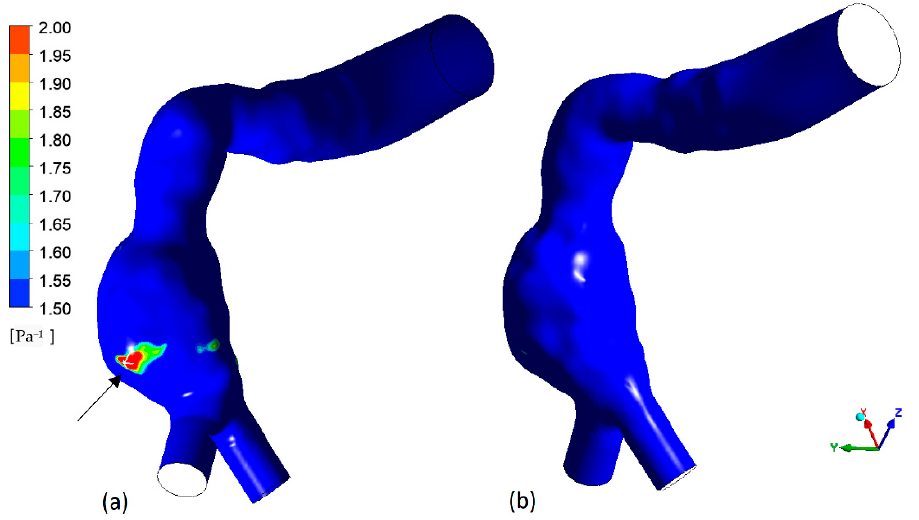
Figure 11. ECAP contours distribution on the luminal surfaces of the rupturing aneurysm: ( a ) front view, ( b ) back view. The arrow and the white cross indicate the region where rupture really occurred (future rupture region).